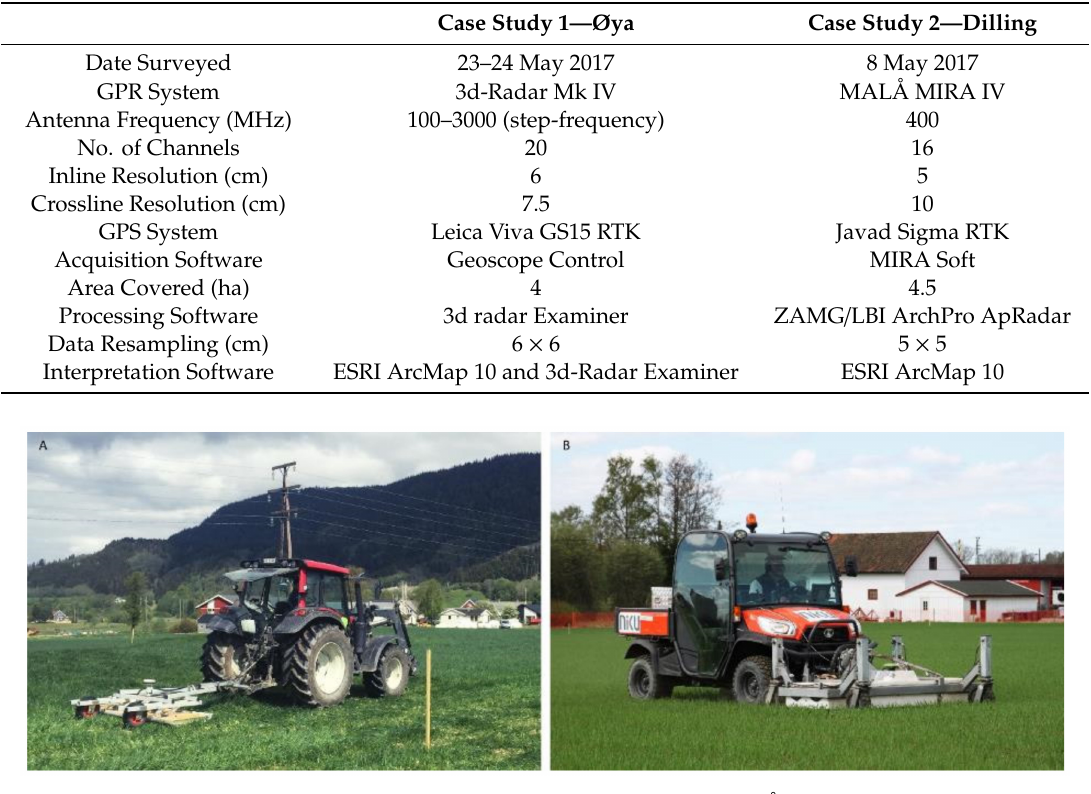
Figure 4. ( A ) 3D Radar Mk IV Geoscope collecting data at Øya. ( B ) MALÅ MIRA III in use at